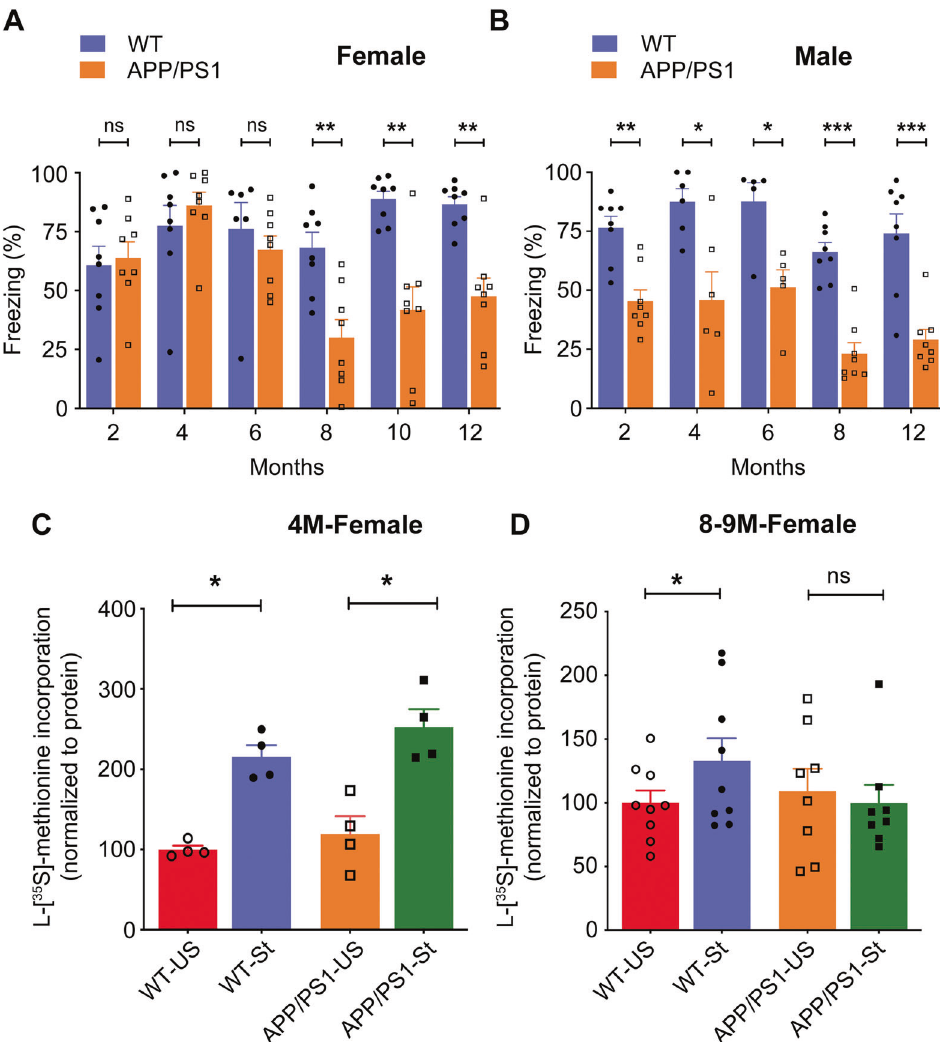
Fig. 1 Impairment in recall memory after contextual fear conditioning depends on sex and age of APP/PS1 mice. A Histograms are showing the freezing response of female mice at different ages. Freezing response was assessed by contextual fear conditioning as percentage of immobility after 24 h of training and no signi fi cant difference was observed in 2 M ( t = 0.2923; df = 14; p = 0.7744; Hedges ’ g (95% CI) 0.14 ( − 0.79, 1.06)), 4 M ( p = 0.4255; Hedges ’ g (95% CI) 0.39 ( − 0.54, 1.32)) and 6 M ( p = 0.1419; Hedges ’ g (95% CI) − 0.37 ( − 1.37, 0.63)) old APP/PS1 female mice compared with WT female mice. Impairment in freezing response was observed in 8 M ( t = 3.794; df = 14; p = 0.0020; Hedges ’ g (95% CI) − 1.79 ( − 2.9, − 0.63)), 10 M ( t = 4.538 ; df = 14; p = 0.0005; Hedges ’ g (95% CI) − 2.14 ( − 3.33, − 0.90)), and 12 M ( t = 4.65; df = 14; p = 0.0004; Hedges ’ g (95% CI) -2.19 ( − 3.40, − 0.94)) old APP/PS1 female mice compared with age matched WT female mice. Statistical analysis: Two-sided t -test or Mann-Whitney U-test was applied to compare WT versus APP/PS1 mouse groups. In all panels, reported values are mean ± s.e.m. * P < 0.05. A , B n = 5 – 8 mice per group. B Histograms are showing the freezing response of male mice at different ages, and APP/ PS1 male mice exhibit signi fi cantly decreased freezing response than the WT male from 2 months onwards. WT versus APP/PS1 male mice, 2 M ( t = 4.594; df = 14; p = 0.0004; Hedges ’ g (95% CI) − 2.17 ( − 3.37, − 0.92)), 4 M ( t = 3.168; df = 10; p = 0.01; Hedges ’ g (95% CI) − 1.68 ( − 2.93, − 0.38)), 6 M ( p = 0.0317; Hedges ’ g (95% CI) − 1.90 ( − 3.32, − 0.42)), 8 M ( p = 0.0002; Hedges ’ g (95% CI) − 3.33 ( − 4.85, − 1.78)), and 12 M ( t = 4.824; df = 14; p = 0.0003; Hedges ’ g (95% CI) − 2.28 ( − 3.50, − 1.01)). Statistical analysis: Two-sided t -test or Mann – Whitney U-test was used to compare WT versus APP/PS1 mouse groups. In all panels, reported values are mean ± s.e.m. * P < 0.05. A , B n = 5 – 8 mice per group. Local activity dependent protein translation at the synapse is signi fi cantly affected in APP/PS1 female mice at 8 months but not at 4 months of age. Synaptoneurosomes from WT and APP/PS1 female mice were stimulated with or without KCl in the presence of 50 μ Ci L-[ 35 S]-methionine at 37 °C for 15 min and newly synthesized proteins (protein translation) were measured by L-[S 35 ]-methionine incorporation assay. C KCl stimulated local protein translation in synaptoneurosomes was not affected between WT and APP/PS1 female mice at 4 months of age (WT-US versus WT-St, t = 6.894 ; df = 3; p = 0.003; Hedges ’ g (95% CI) 4.61 (1.78, 7.40); APP/PS1 -US versus APP/PS1 -St, t = 3.042; df = 3; p = 0.028; Hedges ’ g (95% CI) 2.59 (0.68, 4.42)). Statistical comparisons from each group (unstimulated versus stimulated) were calculated using paired, one-sided, student t- test. n = 4 mice per group. D Stimulation of local protein translation in synaptoneurosomes in the presence of KCl was impaired in APP/PS1 female mice with comparison to WT female mice at 8 months of age (WT-US versus WT-St ( t = 2.960; df = 8; p = 0.009; Hedges ’ g (95% CI) 0.72 ( − 0.19, 1.63)) ; APP/PS1 -US versus APP/PS1 -St ( t = 0.341; df = 7; p = 0.372; Hedges ’ g (95% CI) − 0.19 ( − 1.11, 0.74))). Statistical comparisons from each group (unstimulated versus stimulated) were calculated using paired, one-sided, student t- test. All values normalized to unstimulated WT group. Data is represented as mean ± s.e.m. ( n = 8 – 9 mice per group) and *denotes values signi fi cantly different from corresponding controls ( p <